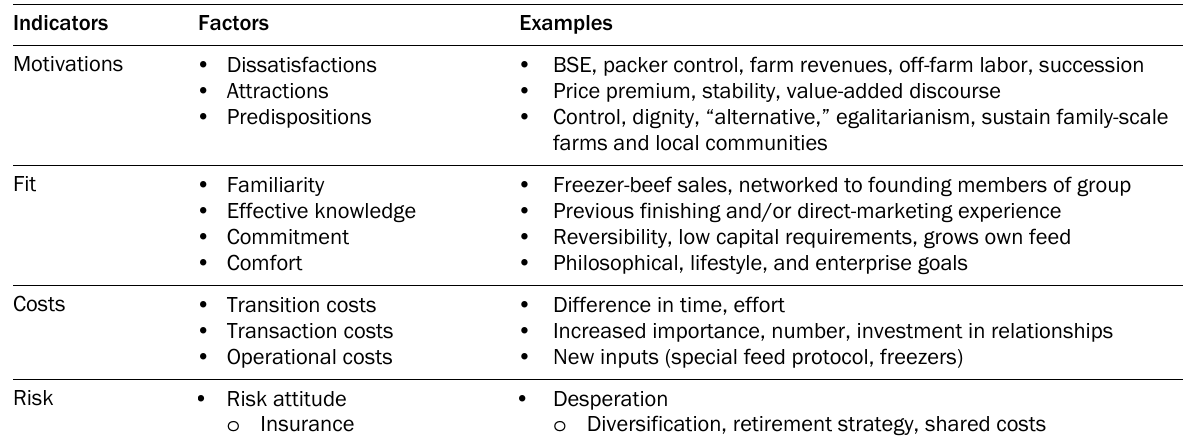
Table 3. Relative Advantage in Direct Market Chains